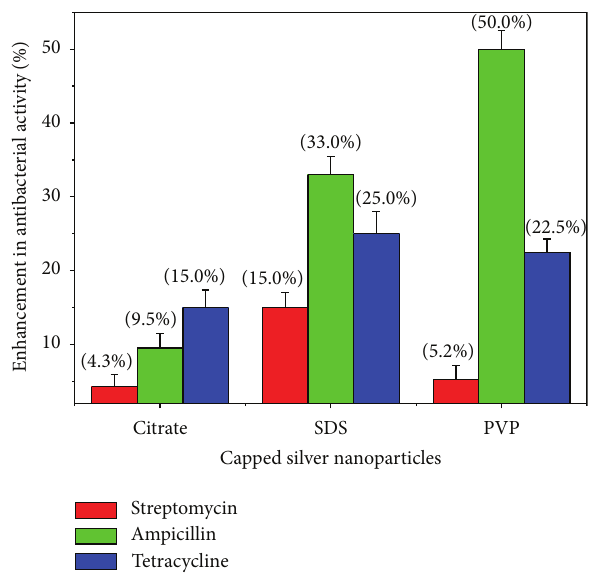
Figure 6: The percentage of enhancement in antibacterial activity observed for the antibiotics in combination with silver nanoparti- cles, against the bacterial strain E. coli ATCC 25922.